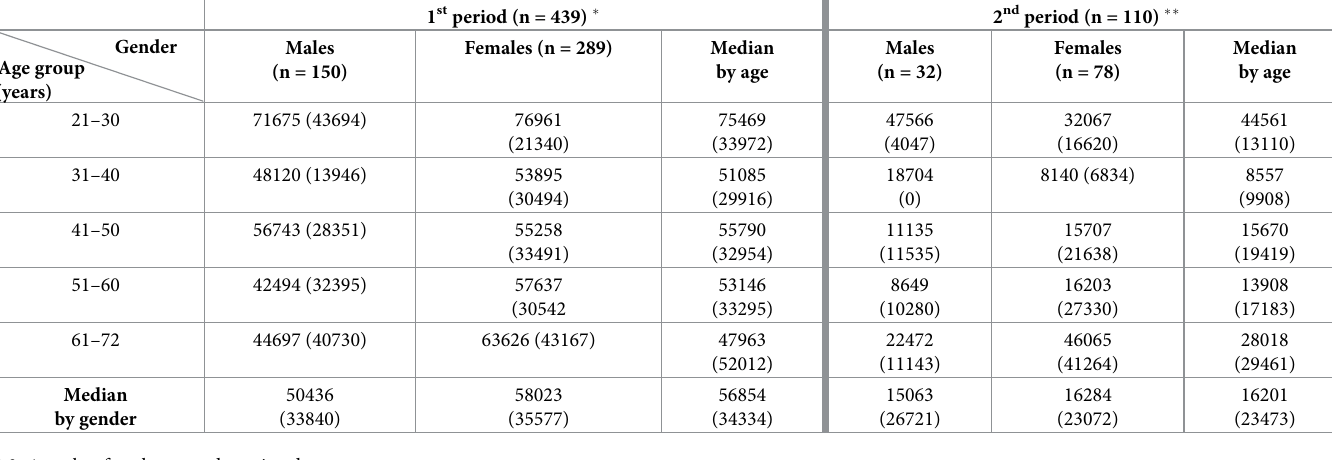
Table 3. SARS-CoV-2 anti-S-RBD IgG antibody titers by age and gender in the two study periods. 1 st period (n = 439)